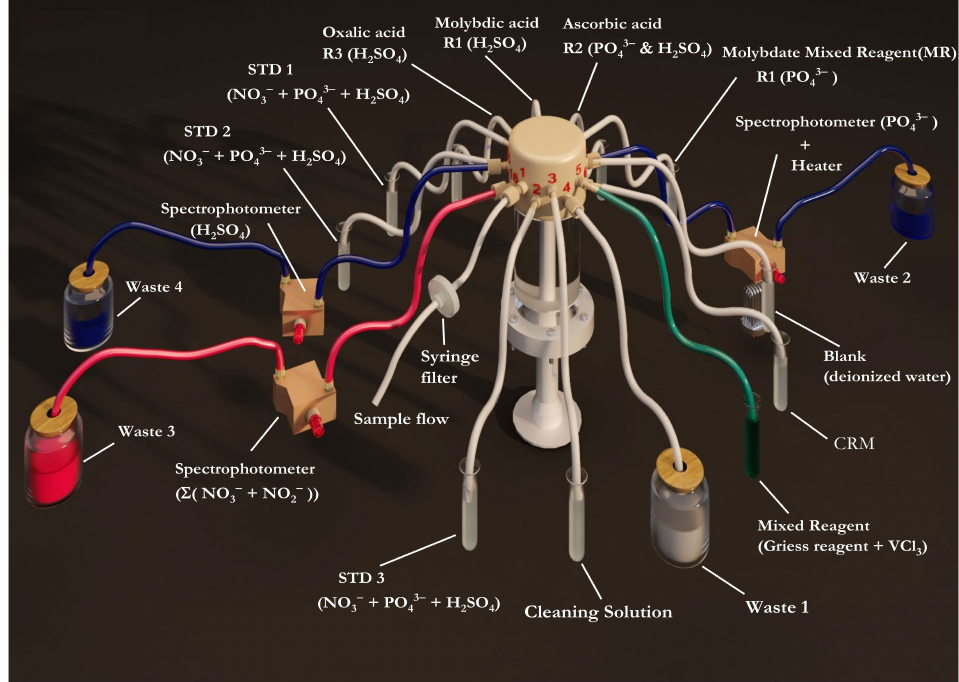
Figure 2. Three-dimensional schematic diagram of the AutoLab autoanalyzer (syringe and 16-way rotatory valve) for multinutrient determination. Standard solutions: STD; certified reference materi- als: